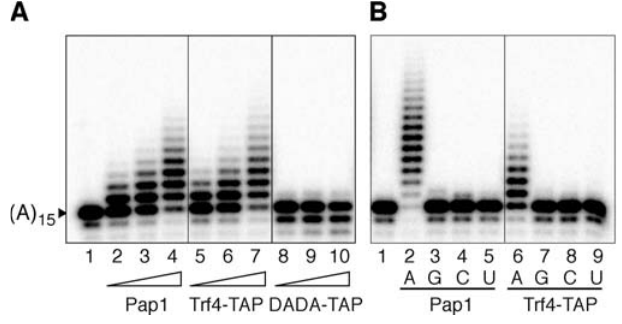
Figure 2. Trf4p Is the Catalytic Subunit of a New Poly(A) Polymerase (A) The Trf4 complex has poly(A) polymerase activity. The 5 9 -end- labeled oligo(A) 15 was incubated 30 min with 5, 10, or 20 ng of affinity-purified fractions of the wild-type TAP-tagged Trf4p (Trf4- TAP) or mutant Trf4p with the aspartic acid residues 236 and 238 changed to alanines (DADA-TAP). Protein was omitted in lane 1. Recombinant yeast poly(A) polymerase (Pap1), 1, 2, and 4 ng, was used as a positive control. The migration position of oligo(A) 15 is indicated by an arrow. (B) The Trf4p activity is specific for the addition of adenosine monophosphate. Polyadenylation assays with 20 ng of Trf4-TAP in the presence of different ribonucleoside triphosphates. Recombinant yeast Pap1p, 5 ng, was used as a control. All samples were separated on 15% denaturing gels. DOI: